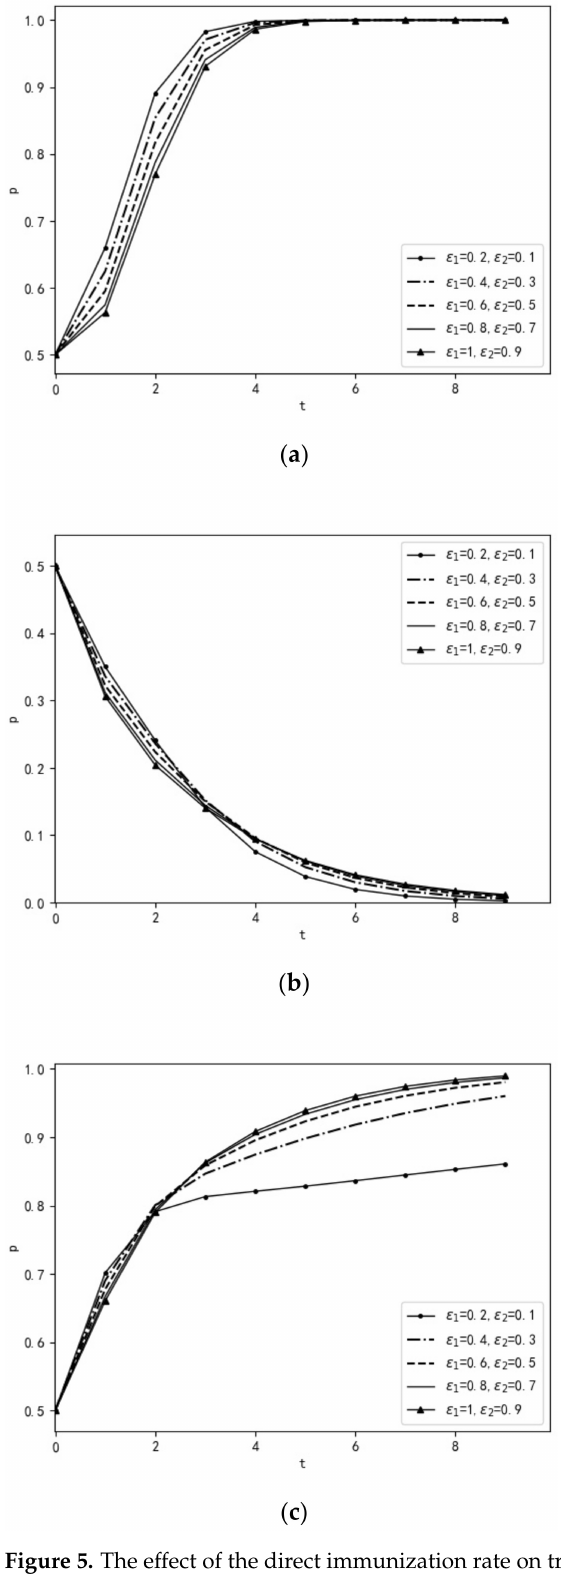
Figure 5. The effect of the direct immunization rate on tripartite strategy evolution. ( a ) The effect of the direct immunization rate on the local government. ( b ) The impact of the direct immunization rate on enterprises. ( c ) The impact of the direct immunization rate on the